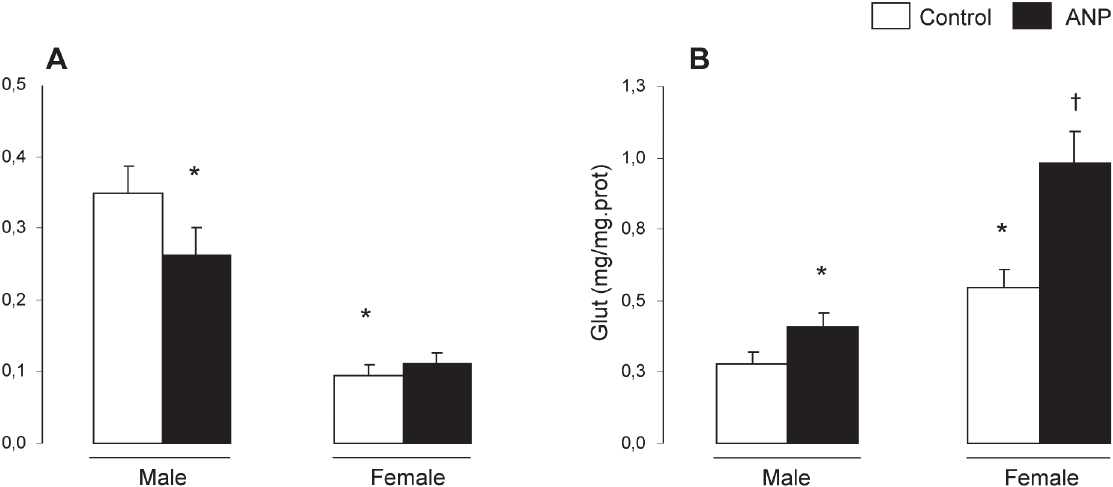
Fig 2. Effects of ANP treatment on renal concentration of glutathione and TBARS. (A) Glut: glutathione; (B) TBARS: thiobarbituric acid reactive substances. Data are mean ± SEM (n = 12). * p < 0.01 vs Control male, † p < 0.01 vs Control female.